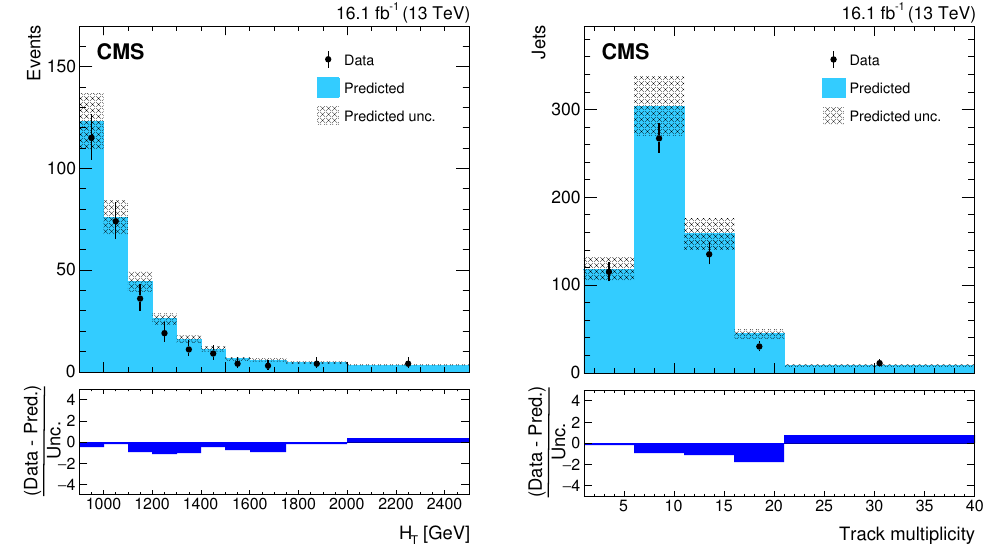
Figure 7 . The H T (left) and number of associated tracks (right) distributions for the observed data events (black points) and the predicted background estimation (blue) for selection set 8 (SM QCD- enhanced), requiring at least two jets tagged by loose emerging jet criteria. The bottom panel shows the di(cid:11)erence between observed data and predicted background, divided by the sum in quadrature of the statistical uncertainty in data and the predicted uncertainties from misidenti(cid:12)cation probability